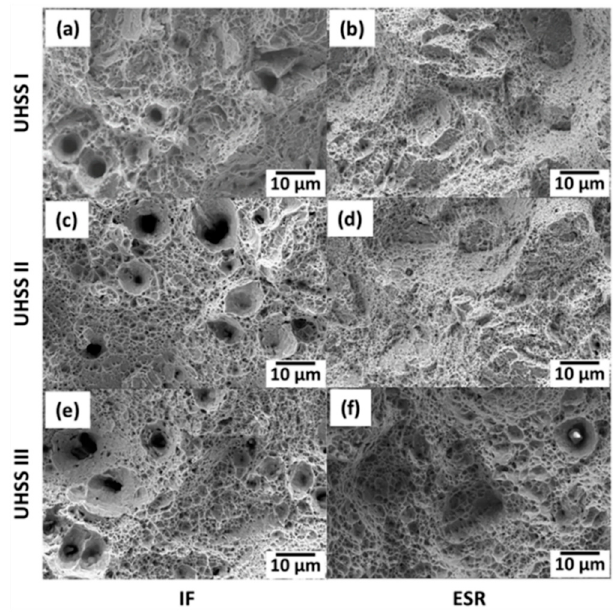
Figure 11. SEM micrograph of fracture surface of tensile test specimens in UHSS I, II, and III without ESR ( a , c, and e ) and with ESR ( b , d, and f ), respectively.